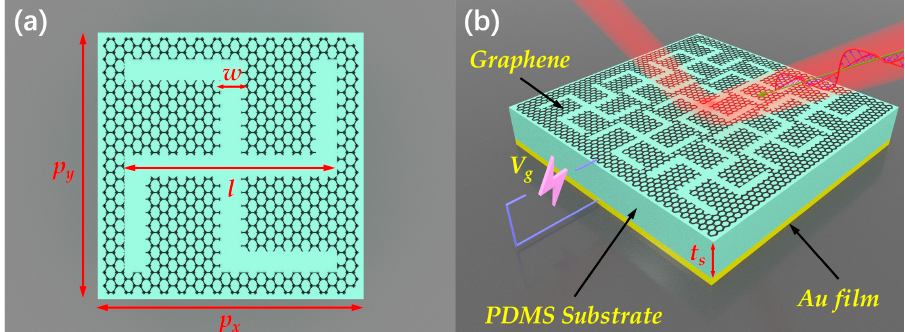
Figure 1. The scheme of designed tunable metamaterial absorber (MMA): perspective views of ( a ) the unit cell structure and ( b ) the two-dimensional array.